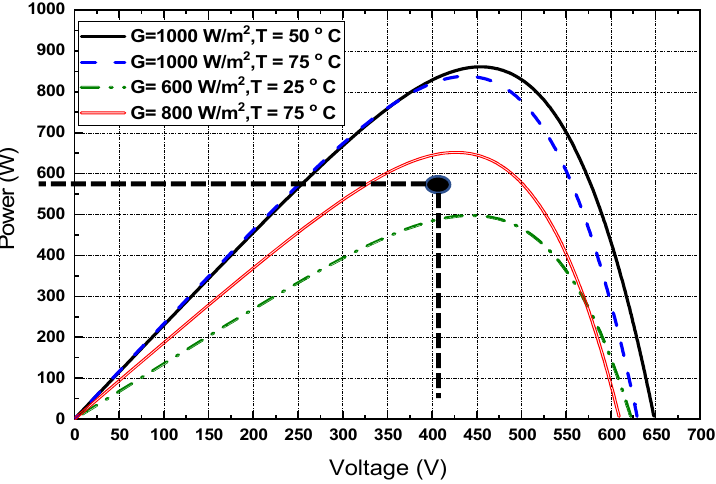
Figure 8. PV characteristics at various solar insolation and temperatures.